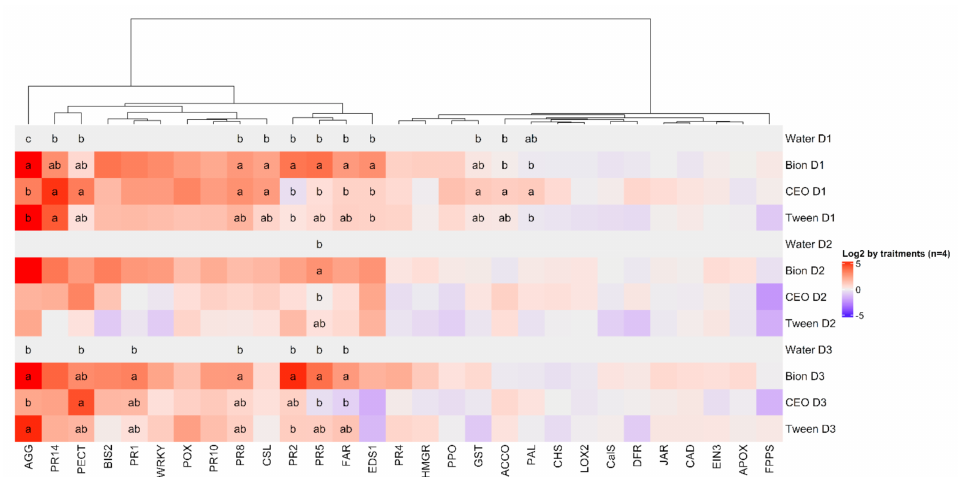
Figure 5. Effect of C. cassia EO (CEO 1% ( v / v )), Bion, tween 80 and water application on mean normalised log 2 expression levels ( n = 4) by days of 29 mRNA transcripts of selected defence genes analysed by heatmap (deviations to the water controls) and the pairwise Conover test with compact letter displays (different letter representing significantly different